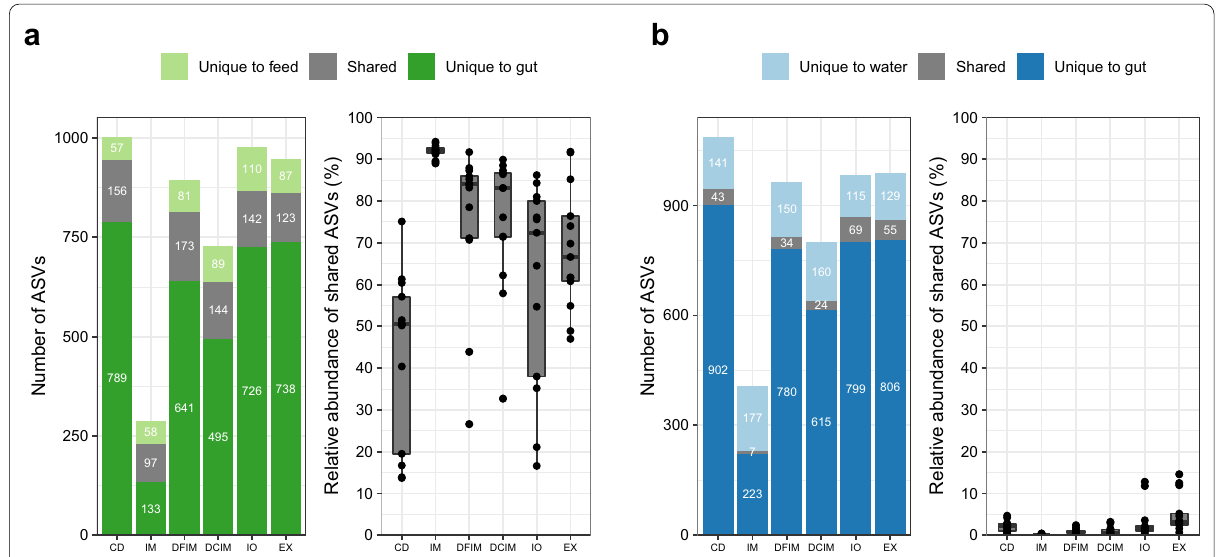
Fig. 5 The microbial overlap between the gut and feeds ( a ) and between gut and water ( b ). The number of shared amplicon sequence variants (ASVs) is shown on the left side in each panel. The relative abundance of shared ASVs is shown on the right side in each panel. The minimum relative abundance of ASVs to be considered as present in a sample was 0.05%. CD control diet; IM full-fat BSF (black soldier fly) larvae meal diet; DFIM defatted BSF larvae meal diet; DCIM de-chitinized BSF larvae meal diet; IO BSF larvae oil diet; EX BSF larvae exoskeleton